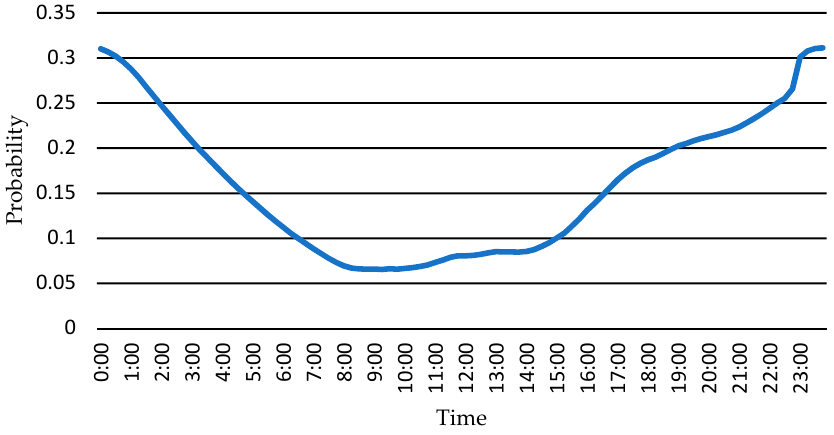
Figure 4. The estimated probability of the AC charger availability.